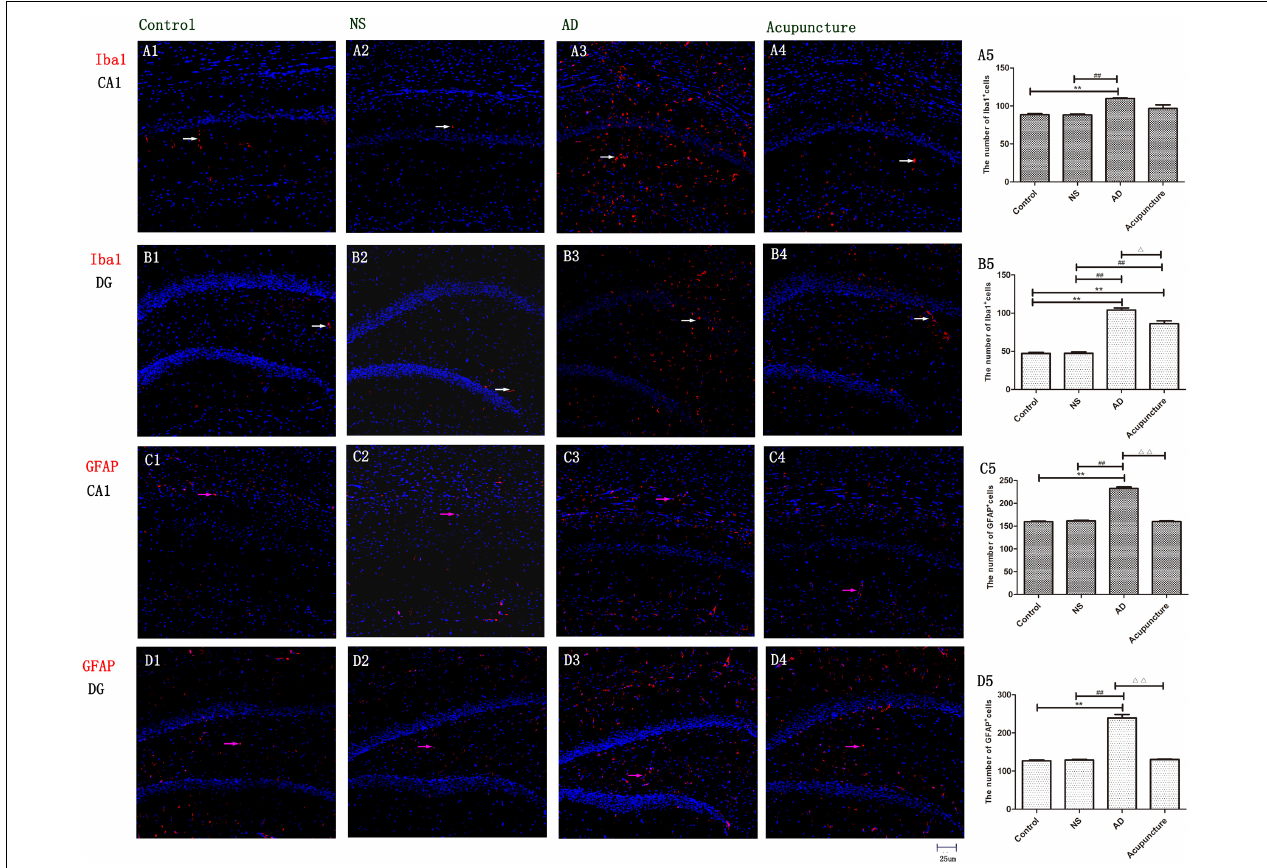
FIGURE 2 | The activation of glia in DG and CA1. (A1–4) Microglia of CA1 were stained with anti-Iba1 in four groups. (B1–4) Microglia of DG were stained with anti-Iba1. (The white arrow express the red Iba1-positive cells.) (C1–4) Astrocyte of CA1 was stained with anti-GFAP. (D1–4) Astrocyte of DG was stained with anti-GFAP (the pink arrow express the red GFAP-positive cells). (A5,B5,C5,D5) The number of positive stained cells in four groups. Error bars: SE. Compared with Control group, ** p < 0.01; compared with NS group, ## p < 0.01; compared with AD group, (cid:77) p < 0.05, (cid:77)(cid:77) p < 0.01 ( n = 5).